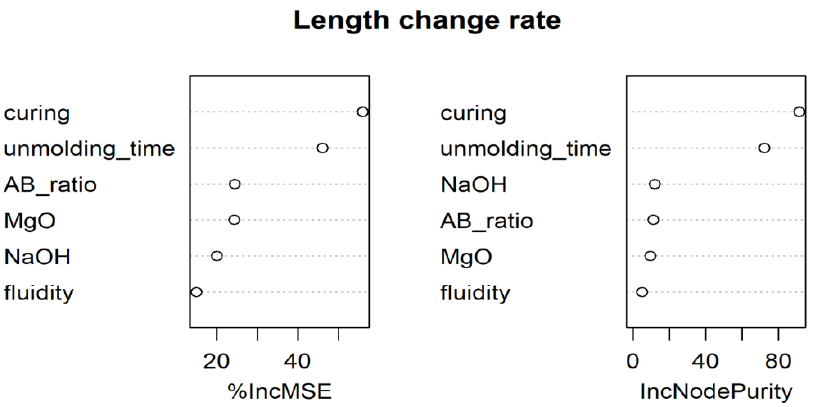
Figure 11. The multiple regression analysis for the length change ratio basing on 124 specimens’ data.